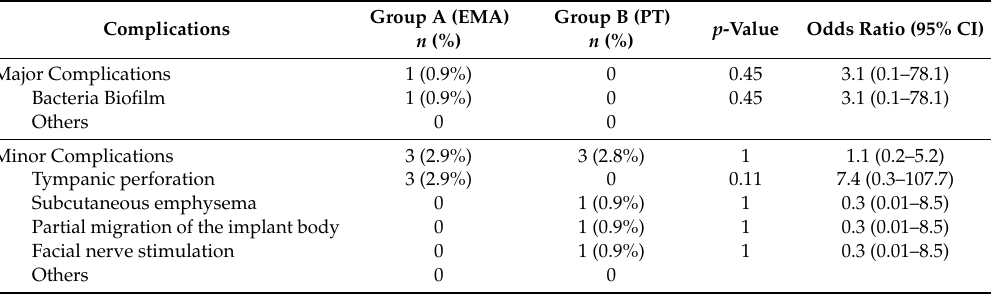
Table 2. Intra- and postoperative